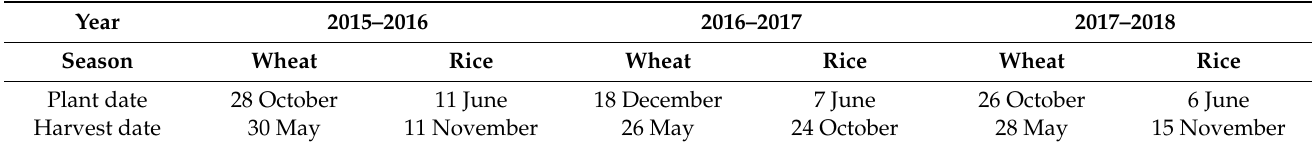
Figure 1. Location and the satellite image from Google Earth taken on 1st October 2018 of the study area ( a ), and the photos of wheat season and rice season, respectively ( b ). Table 1. Planting and harvest date in the rice-wheat rotation agroecosystem.